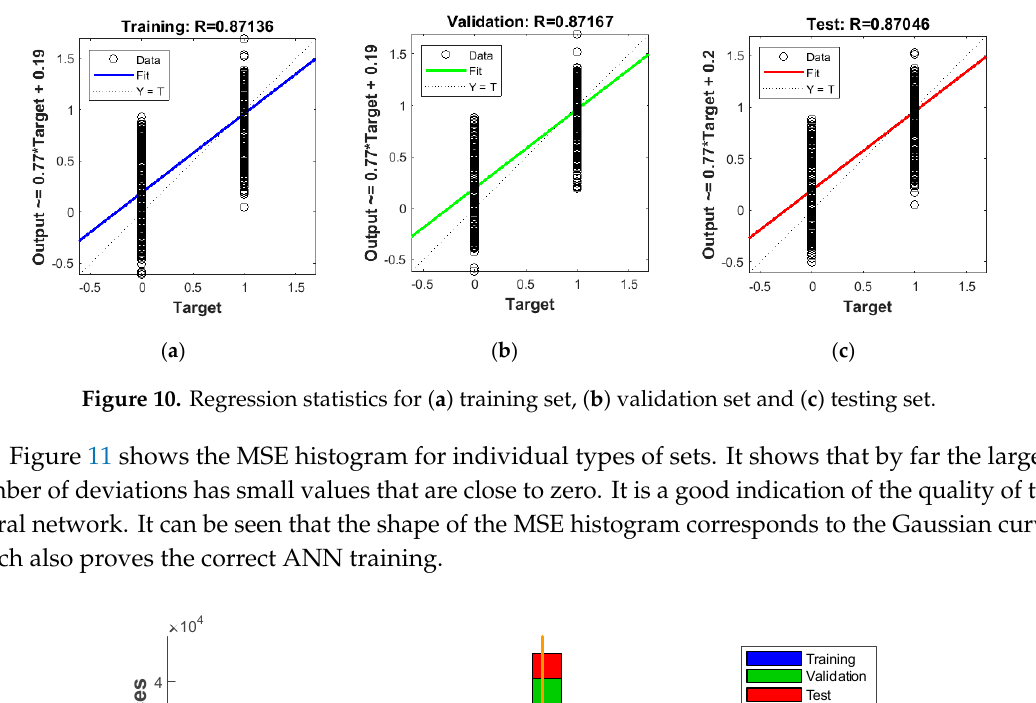
Figure 9. The training and validation process of the EIT-UST network: ( a ) early stopping method; ( b ) performance chart through the mean square error (MSE).